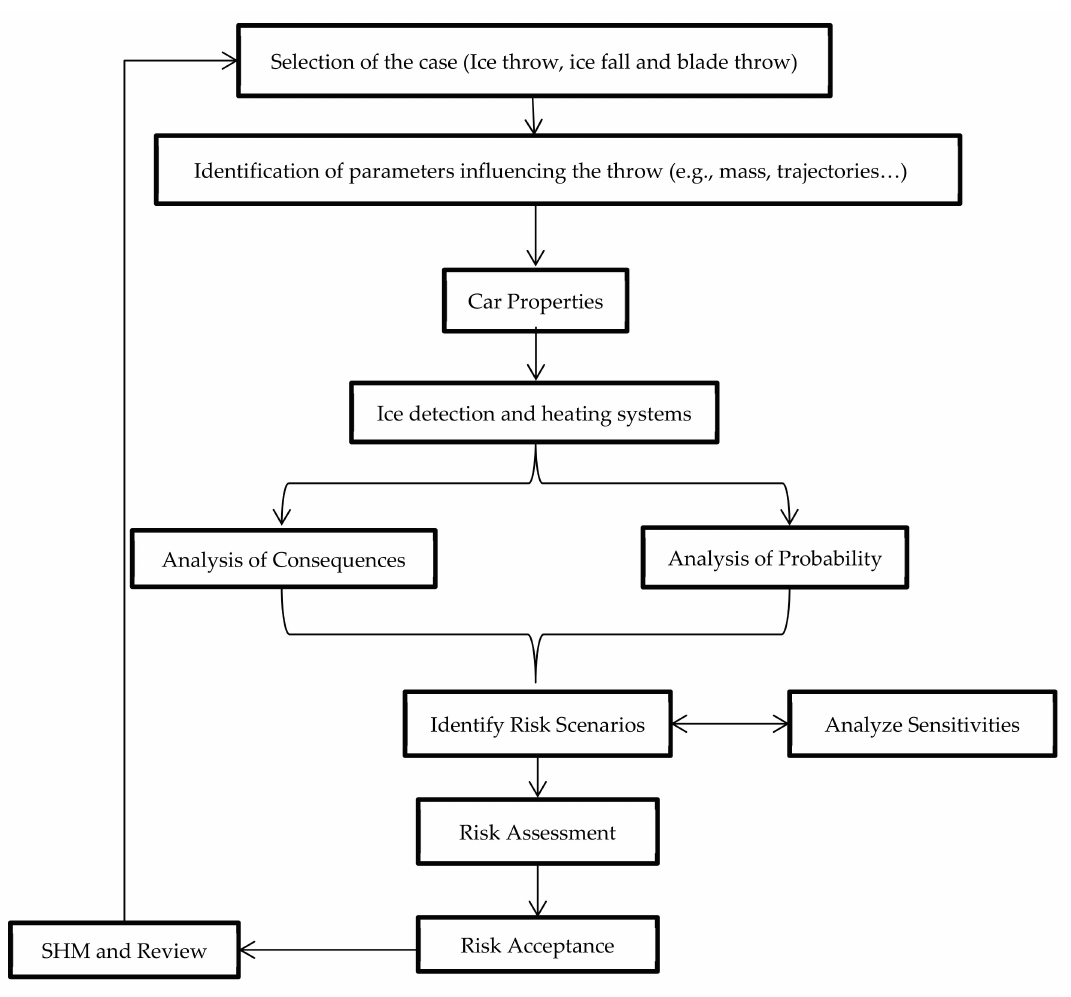
Figure 2. Risk-based decision analysis in this case